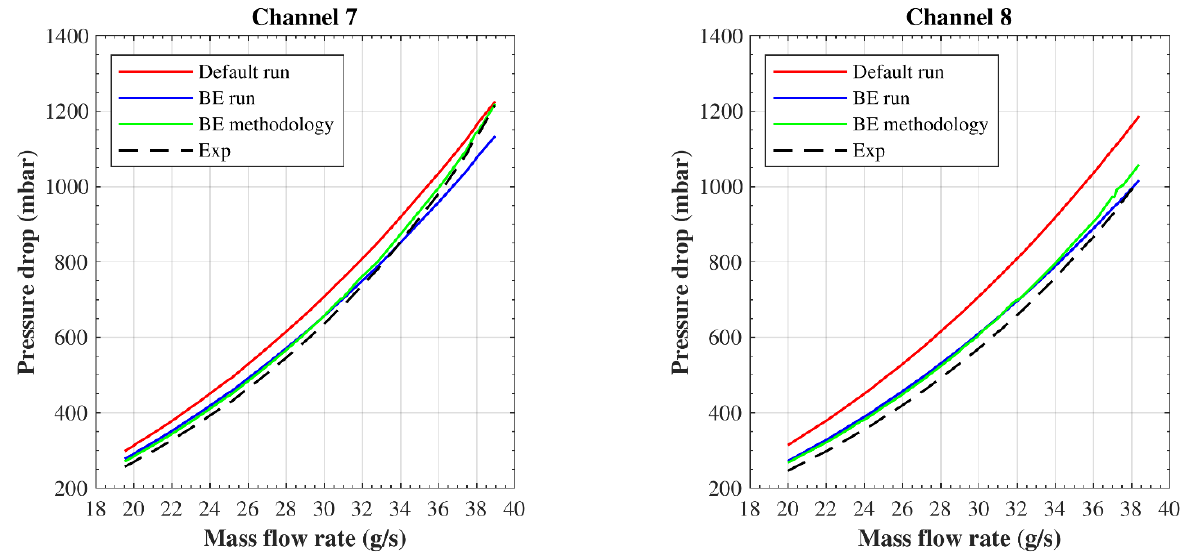
Figure 5. Results of the pressure drop characterization tests on two channels of the first wall mock-up (taken from